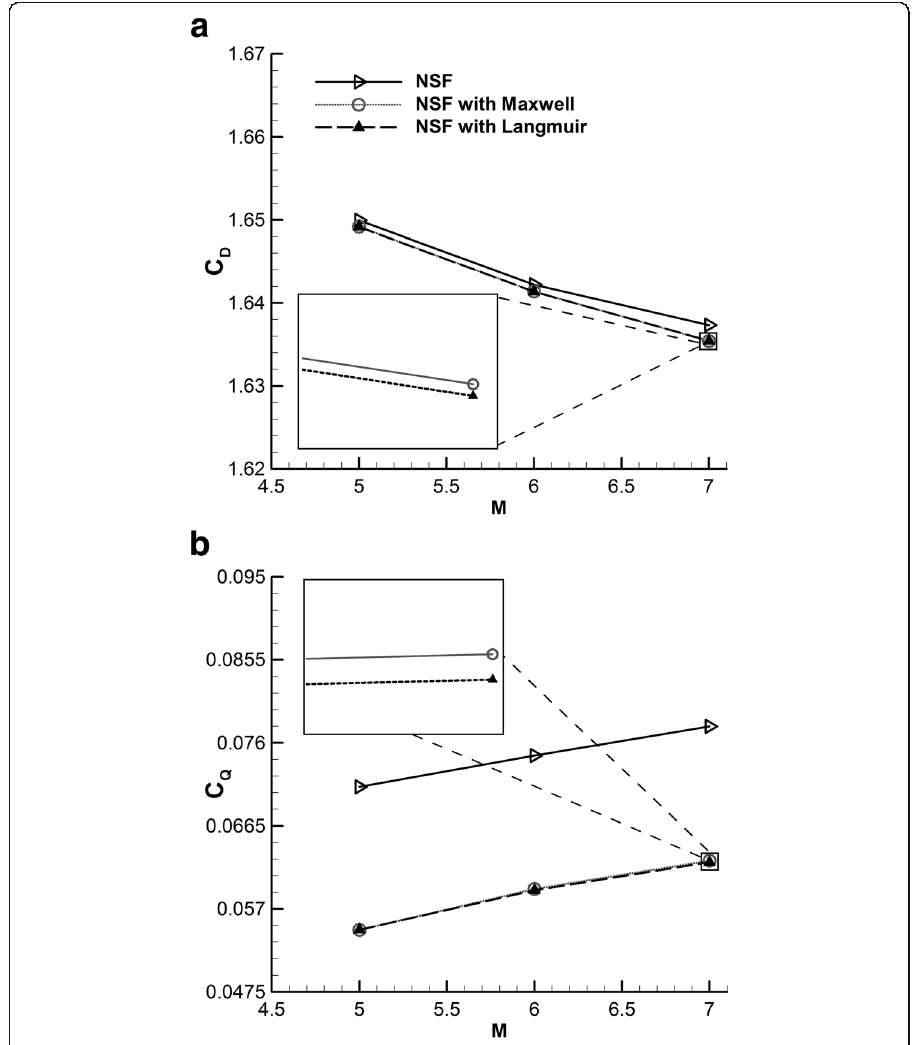
Fig. 8 Comparison of the aerothermodynamic properties for varying Mach numbers (5, 6, and 7) at Kn = 0.005: a drag coefficient, and b heat flux